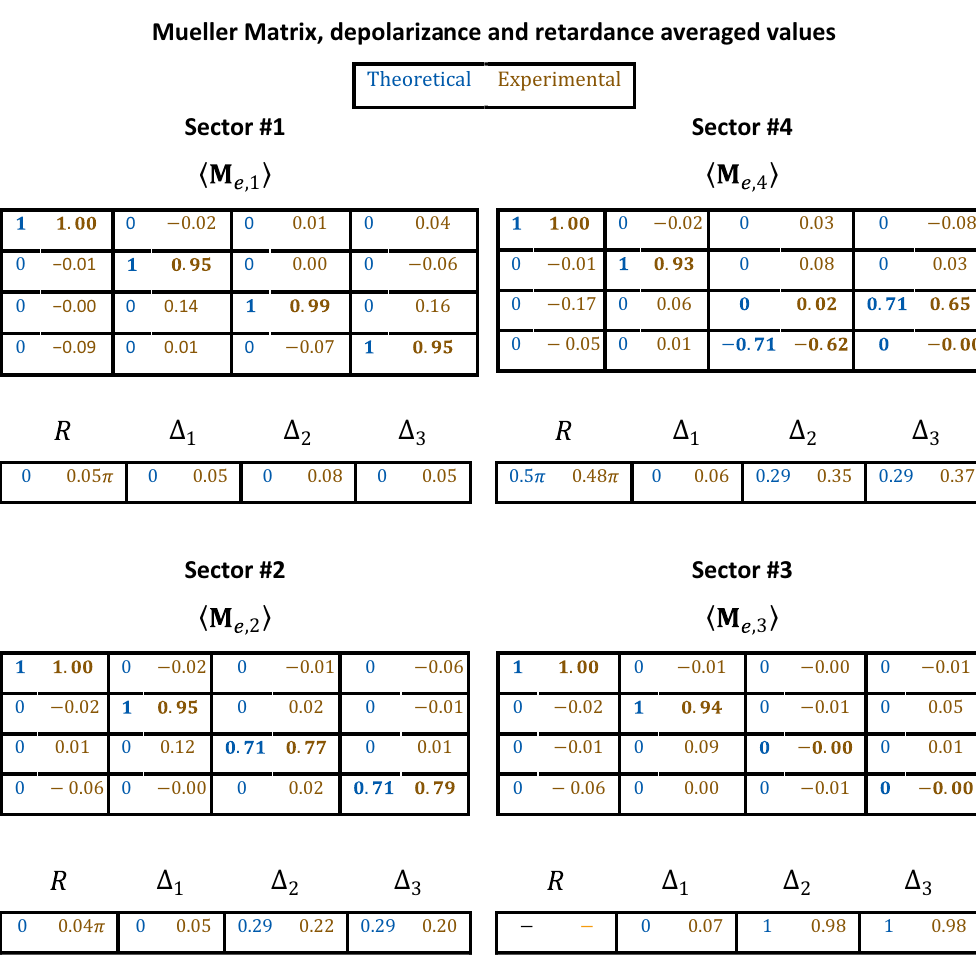
Table 1. Experimental and theoretical effective Mueller matrices, depolarizance (� 1 , � 2 , � 3 ) and retardance ( R ) averaged values, as presented in Fig. 5.